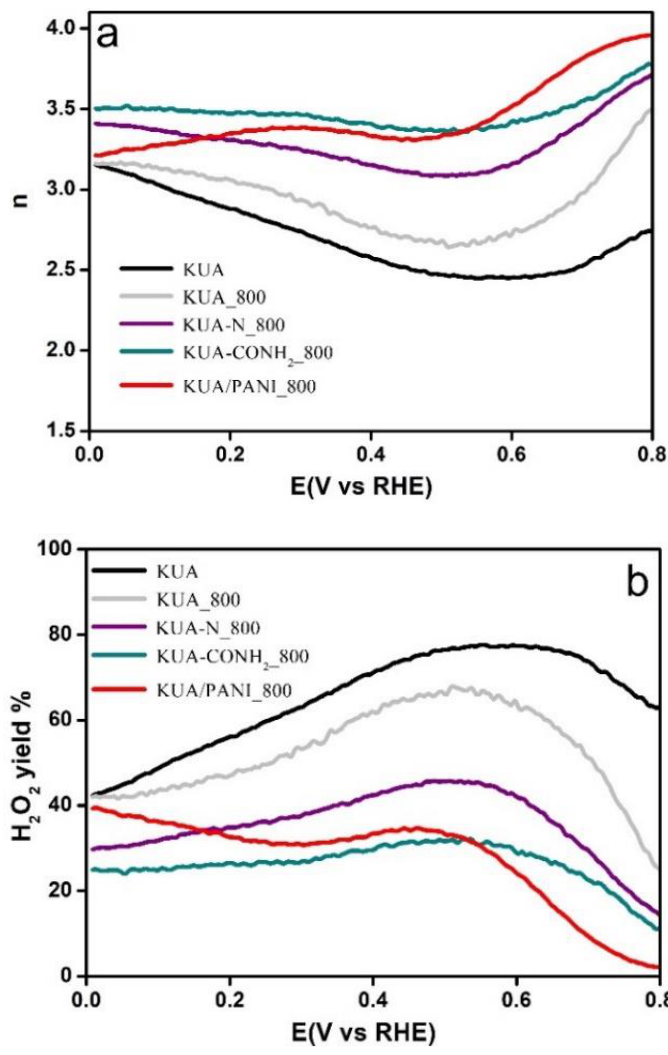
Figure 5. ( a ) Electron transfer number and ( b ) H 2 O 2 yield calculated from RRDE experiments of activated carbon electrocatalysts in O 2 -saturated 0.1 M KOH at 5 mV/s and 1600 rpm.